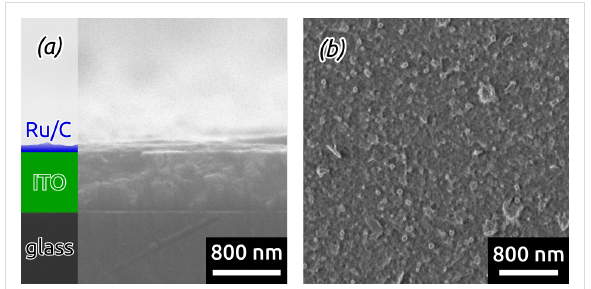
Figure 4: SEM images of planar samples coated with laser-induced Ru/C films in cross-section (a) and top-view (b). Laser-irradiation of Ru 3 (CO) 12 solutions results in continuous and rough thin films deposited on ITO.